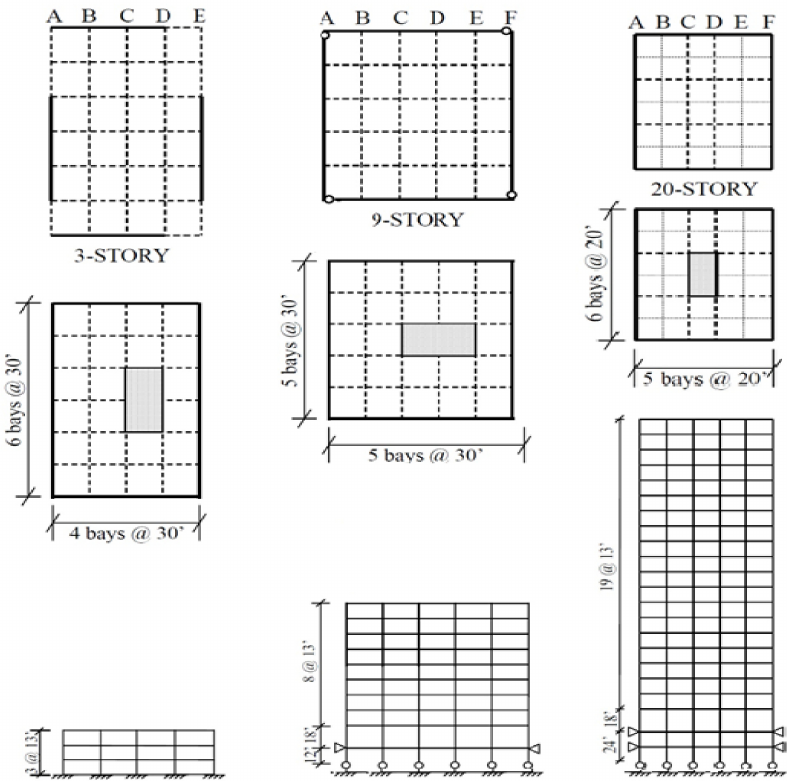
Figure 8. Floor plans and elevations of the considered 3-, 9-, and 20-story buildings [29].